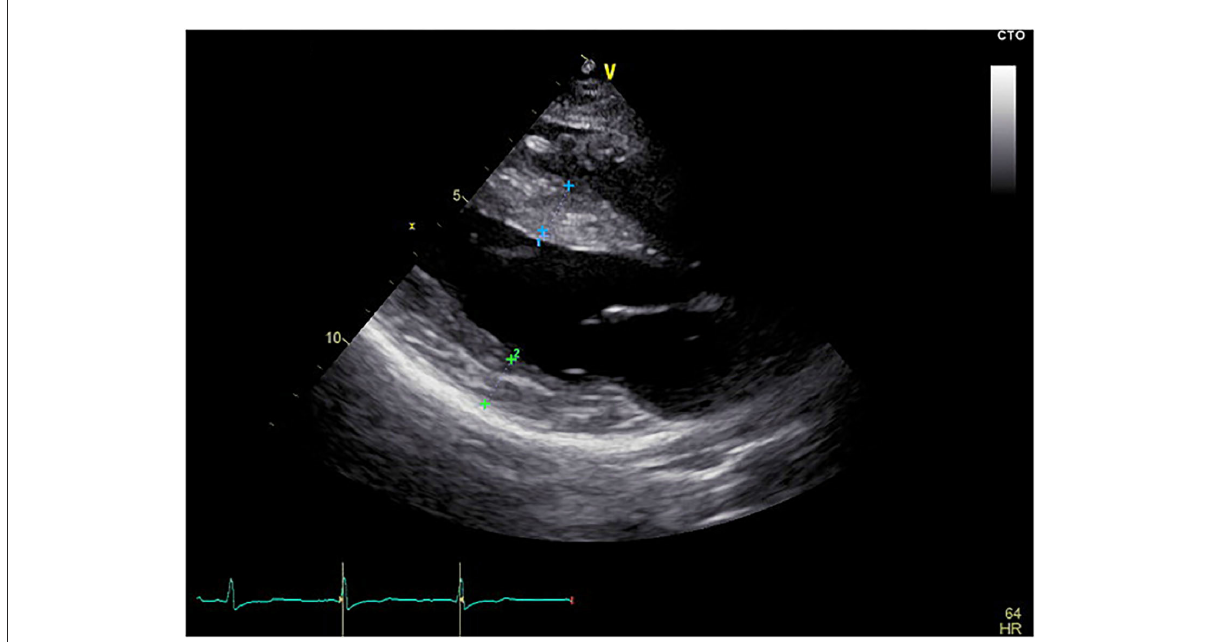
FIGURE1 Echocardiogram of the patient. The echocardiogram showed thickened interventricular septum and left ventricular posterior wall. Blue cross marked part: interventricular septum, thickness was 1.4cm; Green cross marked part: posterior wall of left ventricle, thickness was 1.4cm; Yellow scale bar shows length in